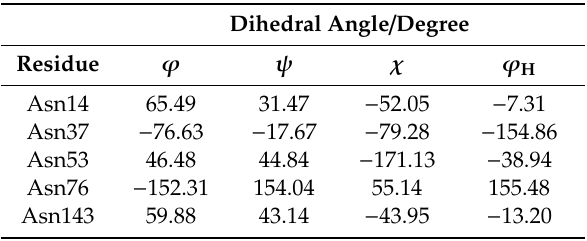
Table 2. Dihedral angles (degrees) of Asn residues in the final structure of the molecular dynamics (MD) simulation.